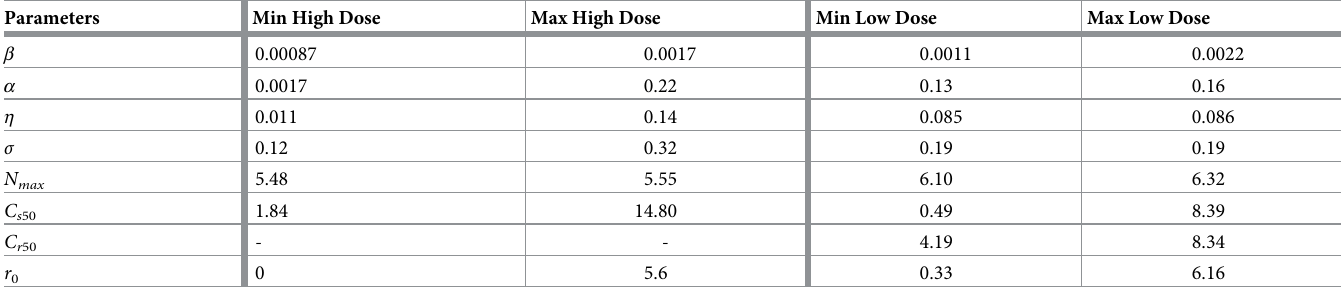
and low dose regimen. We bound our parameters by +/-3 of the standard deviations. The max- imum r is bound on the upper side, by the initial amount of E. coli . During our simulations, 0 we compared how the parameter changes affected the area under the curve of the amount of bacteria above the ECOFF. We simulate model outcomes for 3,500 simulations across the parameter space during the high dose regimen (500 variations of the 7 parameters). In the left panel of Fig 6, we plot the Table 2. Sensitivity analysis parameter ranges.